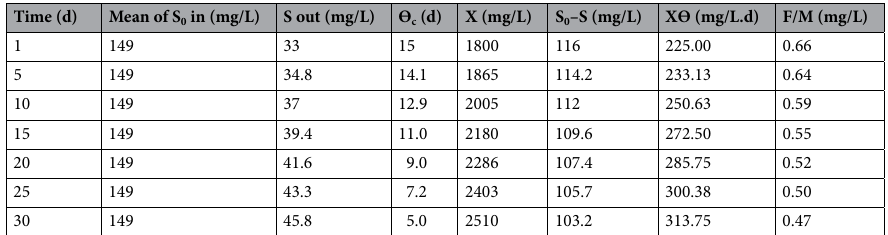
Table 6. Change of operational and functional parameters by application of the SMFs on ASM 3.